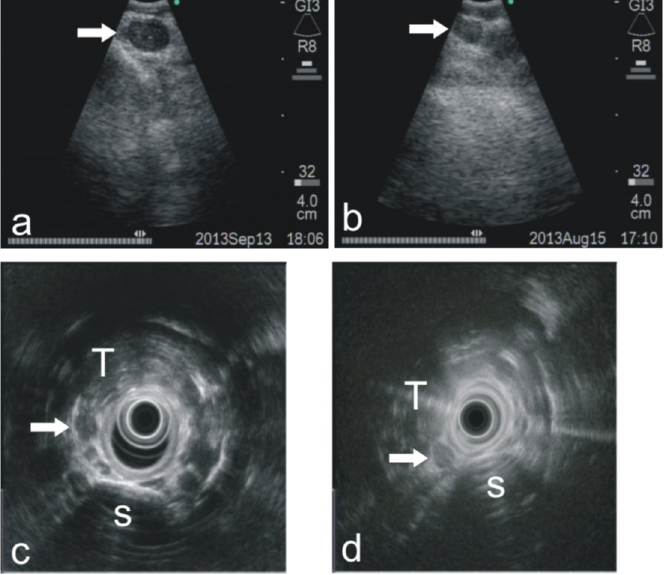
Fig 1. Representative images for EBUS and EUS in detecting RLN lymph node metastases. ( a) An EBUS image showed an enlarged right RLN lymph node with a round shape, a distinct margin and a hypoechoic internal echo with obliterated hilar architecture. The lymph node metastases was diagnosed by EBUS. The patient accepted radical resection of the esophageal carcinoma. The postoperative pathology proved right RLN lymph node metastases. (b) An EBUS image indicated a benign right RLN lymph node with an iso-echoic internal echo and indistinct margin and non-round shape. The postoperative pathology showed a negative result at the right RLN lymph node group. (c) An EUS image indicated a metastatic right RLN lymph node with a round shape and a hypoechoic internal echo with obliterated hilar architecture. The postoperative pathology proved right RLN lymph node metastases. (d) An EUS image indicated a benign right RLN lymph node with an iso-echoic internal echo and non-round shape. The postoperative pathology showed a negative result for the right RLN lymph node group. T, trachea; S, spine.